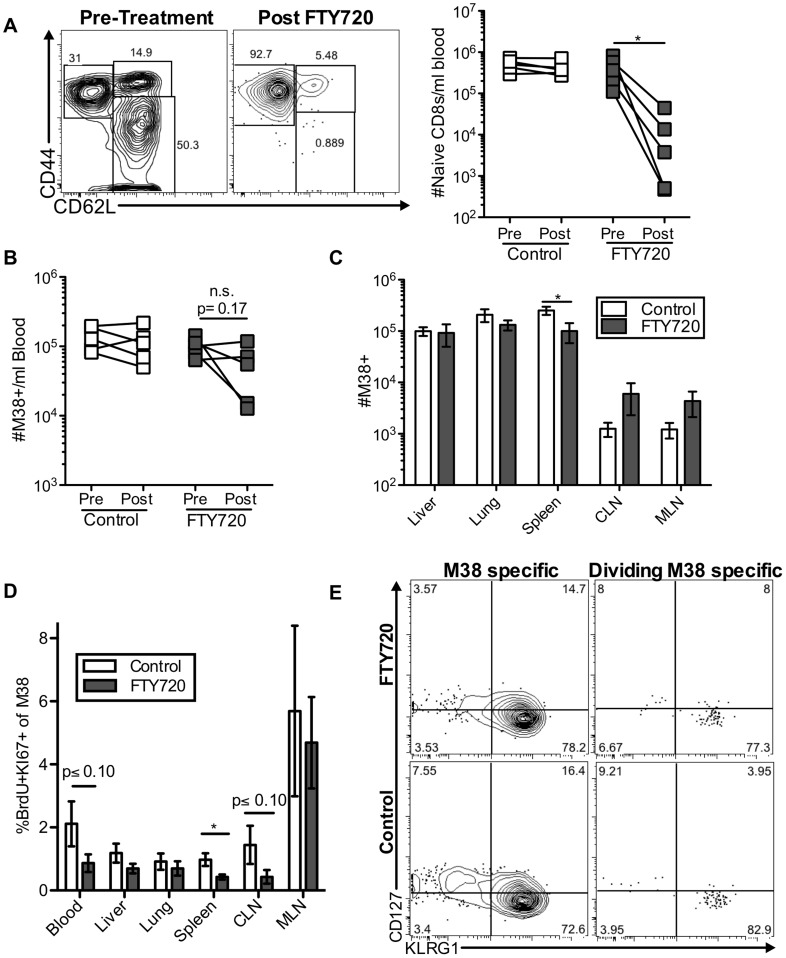
Short-term FTY720 treatment does not alter the pattern of division of inflationary cells.Mice chronically infected with K181 were treated with FTY720 for one week and then injected with BrdU 16(A) Naïve T cells are lost from the blood during FTY720 treatment. The representative FACS plots show the expression of CD44 and CD62L on blood-localized CD8 T cells before (left) and after (right) FTY720 treatment. The graph shows the number of naïve CD8s per milliliter of blood in control and treated mice before and after the treatment. Each line represents an individual mouse (n = 5 per group). (B) M38-specific T cells are only slightly reduced with FTY720 treatment in some mice. Shown is the number of M38-specific CD8s per milliliter of blood in control and treated mice before and after the treatment period. (C) FTY720 treatment has a minimal effect on M38-specific CD8 T cells associated with various organs. Shown are the absolute numbers of M38-specific CD8 T cells harvested with the indicated organs of control (white) and FTY720 treated (grey) mice. (D) Dividing M38-specific T cells are detected systemically even after FTY720 treatment. Shown is the frequency of M38-specific CD8s associated with the indicated organs that were Ki67-positive and labeled with BrdU. (E) Dividing M38-specific T cells are still predominantly effector phenotype. The representative FACS plots show KLRG1 and CD127 expression of M38-specific T cells (left panels) and the dividing M38-specific population in the blood (right panels) for FTY720 treated mice (top panels) and control mice (bottom panels). Data is pooled from two independent experiments (n = 5 per group). In all cases, error bars represent the standard error of the mean. Statistical significance was measured by paired (A and B) or unpaired (C and D) student's t-test (*p<.05).